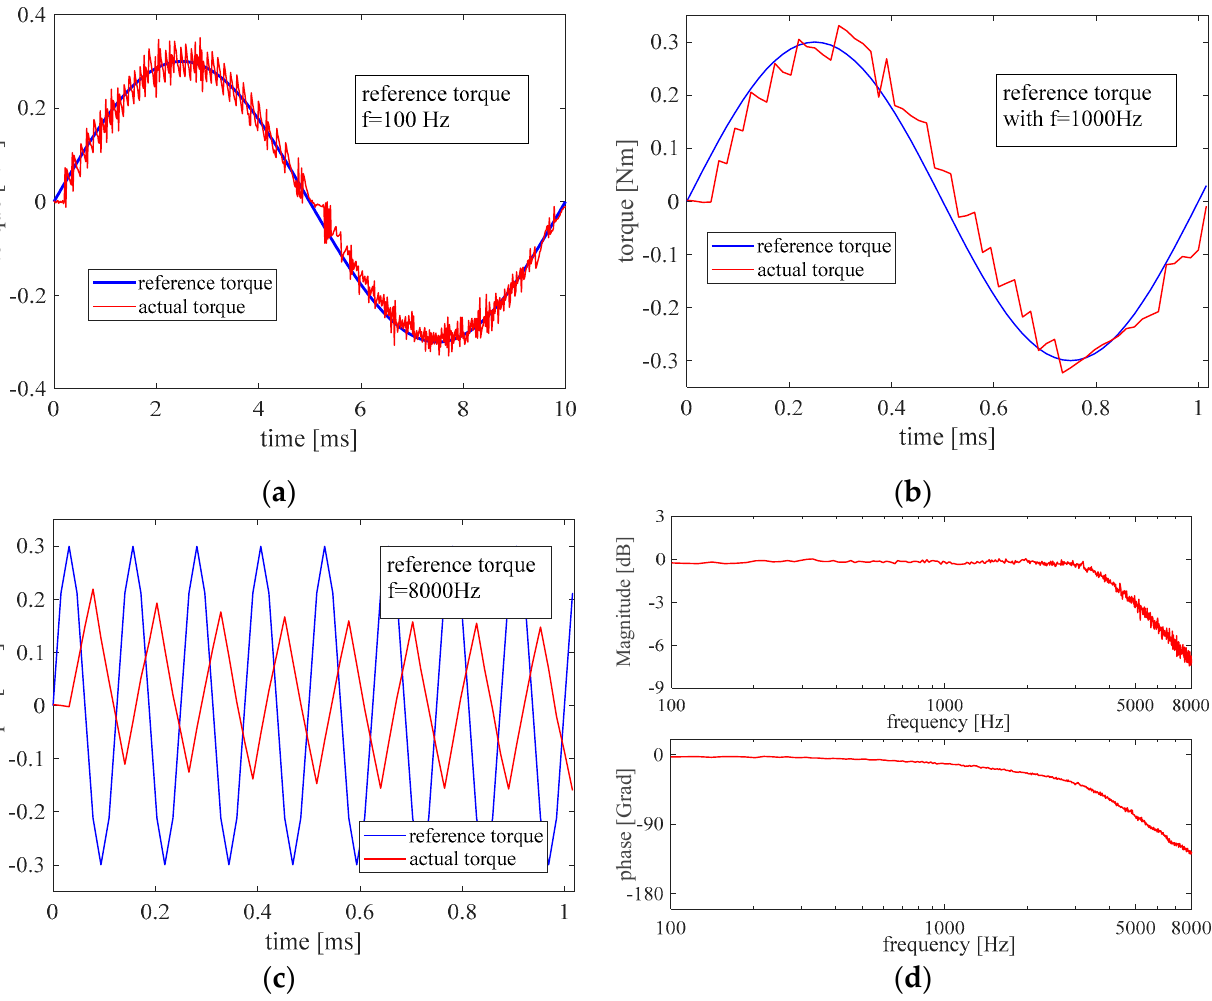
Figure 11. Sine tracking performance with the frequency of 100 Hz ( a ), 1000 Hz ( b ), and 8000 Hz ( c ), and the Bode plot of the closed torque control loop ( d ).